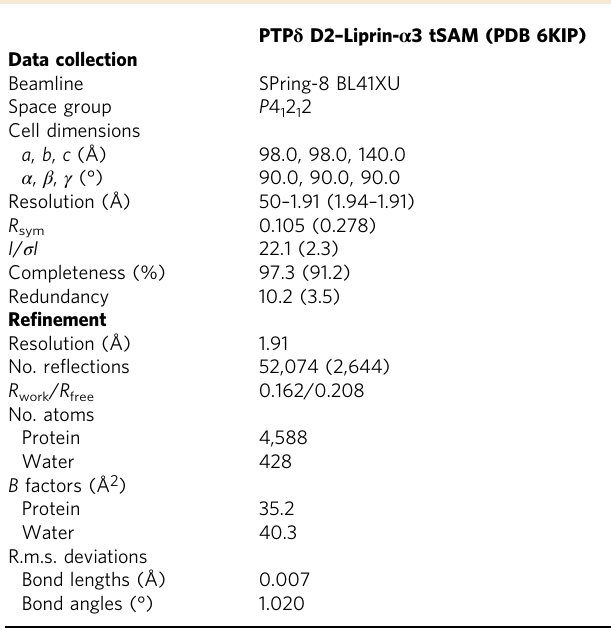
Table 1 Data collection and re fi nement